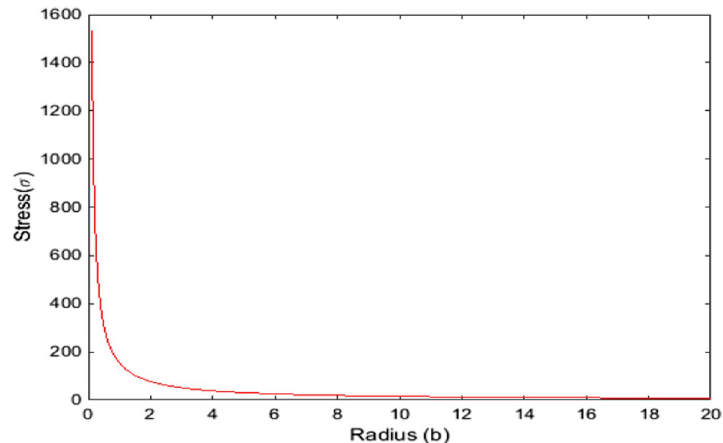
Fig. 2 Variation of σ ψ z ( R , ψ) with